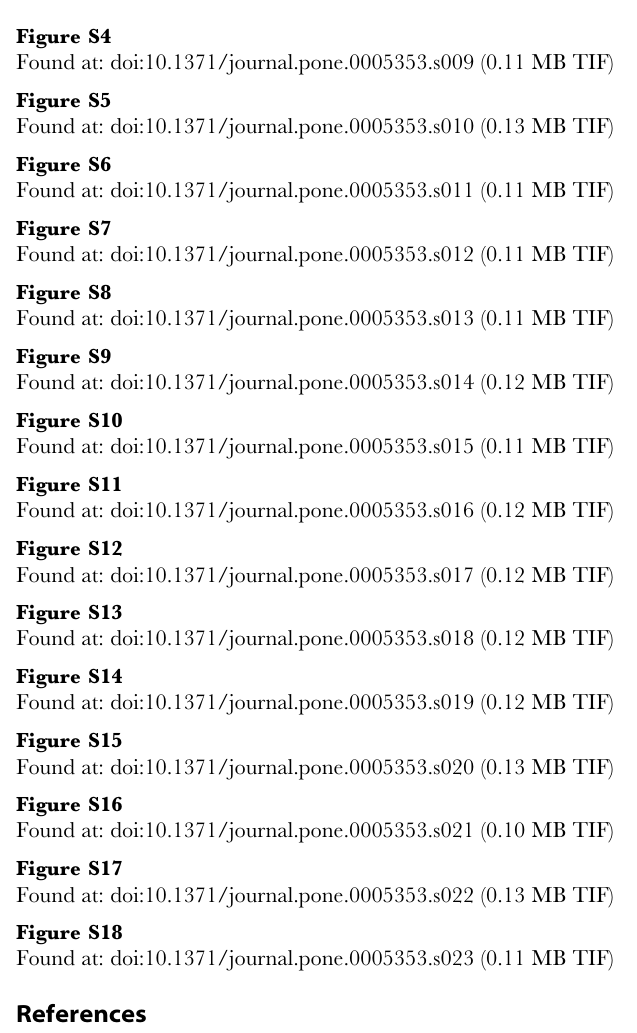
Figure S19 Found at: doi:10.1371/journal.pone.0005353.s024 (0.12 MB TIF) Figure S20 Found at: doi:10.1371/journal.pone.0005353.s025 (0.11 MB TIF) Figure S21 Found at: doi:10.1371/journal.pone.0005353.s026 (0.12 MB TIF) Figure S22 Found at: doi:10.1371/journal.pone.0005353.s027 (0.11 MB TIF) Figure S23 Found at: doi:10.1371/journal.pone.0005353.s028 (0.13 MB TIF) Figure S24 Found at: doi:10.1371/journal.pone.0005353.s029 (0.11 MB TIF) Figure S25 Found at: doi:10.1371/journal.pone.0005353.s030 (0.13 MB TIF) Figure S26 Found at: doi:10.1371/journal.pone.0005353.s031 (0.12 MB TIF) Figure S27 Found at: doi:10.1371/journal.pone.0005353.s032 (0.13 MB TIF) Figure S28 Found at: doi:10.1371/journal.pone.0005353.s033 (0.11 MB TIF)